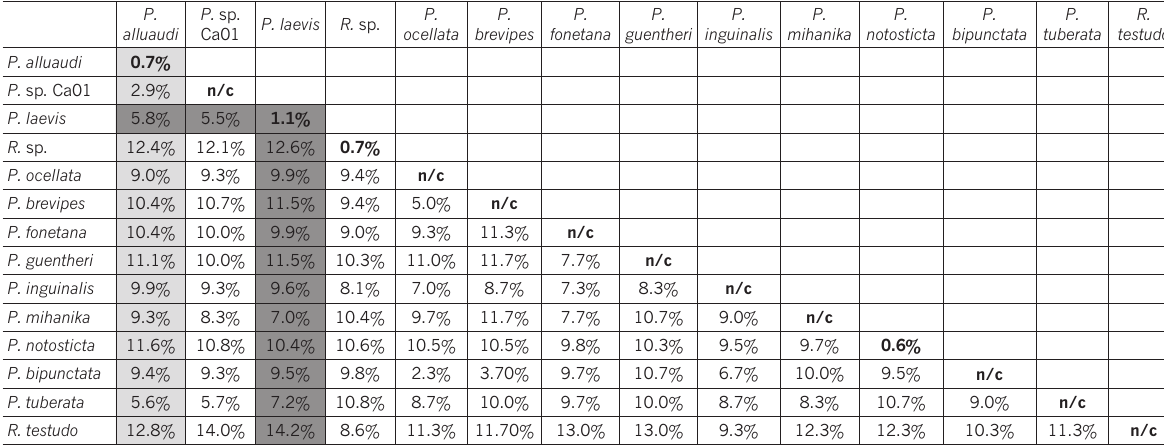
Table 4. Estimates of evolutionary divergence over sequence pairs within- (bold) and between-species for the analysed 16S rRNA mitochondrial gene fragment. The number of base differences per site averaged over all sequence pairs within and between groups are shown. The analysis involved 28 nucleotide sequences. All positions containing gaps and missing data were eliminated. There were a total of 300 positions in the final dataset. Evolutionary analyses were conducted in MEGA7 (Kumar et al. 2016). The pres - ence of n/c (not computed) in the results denotes cases in which it was not possible to estimate evolutionary distances. ‘ R . sp.’ refers to the undescribed Rhombophryne species formerly assigned to R. alluaudi